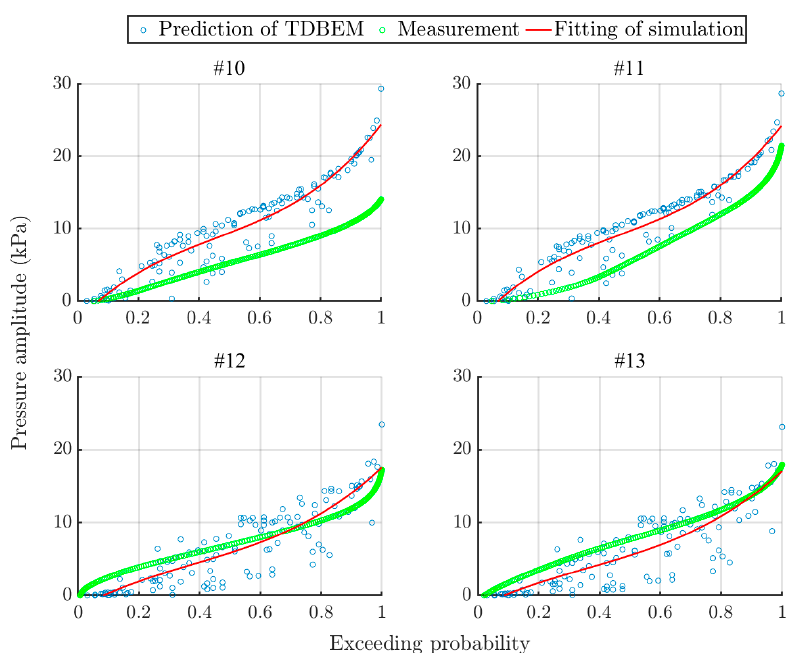
Figure 14. Probability distributions of the pressure amplitude at − 6.37 m. For the discussion, the horizontal axis is assigned to the exceeding probability and the vertical is the pressure amplitude. Each subplot illustrates the comparison at each transducer location. The green scatter plot shows the probability distribution of the meas- ured wave pressure amplitude, while the blue shows the predicted probability distribu- tion which is fitted by the red line. In the comparison at the altitude of − 2.37 m, as shown in Figure 13, the error mainly occurs in the low-exceeding-probability range of the trans- ducers located in the up-wave side, i.e., the results of #2–#4 whose predictions are greater than the measurements. While in the down-wave side, the error mainly occurs in the high- exceeding-probability range, such as #7 and #8, among which the prediction of #7 is greater than the measurement while it is contrary for #8. At the altitude of − 6.37 m, the predictions in the up-wave side are greater than the measurements as shown in results of #10 and #11, while the predictions in the down-wave side are relatively lower than the measurements over the low-exceeding-probability range, as shown in results of #11 and #12. In addition, with increasing the water sinking depth, the margin of error in the com- parison is increased, particularly for the up-wave side, which accounts for the large bias occurred in the previous comparison of pressure spatial distribution. 6. Conclusions This article aims to present the hydrodynamic wave pressure comparison between the on-site measurement and the numerical prediction modeled by time domain bound- ary element method (TDBEM). Based on the temporary cofferdam used in the construc- tion of Pingtan Strait Bridge, the on-site measurement is introduced and was performed during the Typhoon Dujuan in 2015. The wave height and period, still water level (SWL), and the wave pressure and direction were successfully recorded during the 17 min of measurement. Several statistical indicators such as the average wave height of the greatest 1/ k waves 1/ k H and the average wave pressure amplitude of the greatest 1/ k pres- sure amplitudes 1/ k P are derived from the measured data for the prediction and the com- parison. Afterwards, the statistical wave conditions are fed to the pressure prediction us- ing a TDBEM model. The time-stepping integration is employed to drive the prediction using the first and fourth order Adams–Bashforth equations, through which the time-var- iant potential can be hence solved. With the measured and predicted pressure results, the